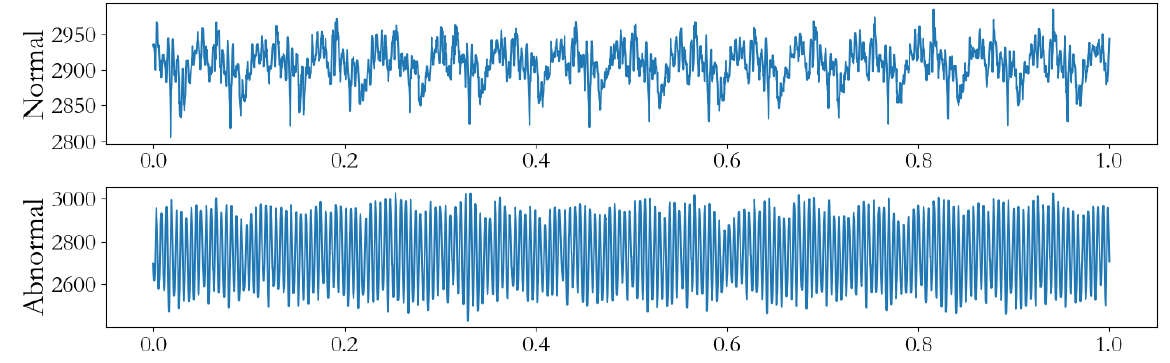
Figure 12. Vibration signals of hydroelectric units.